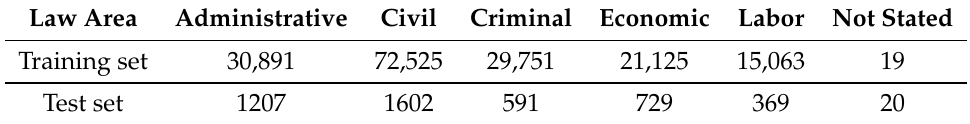
Table 2. Number of documents belonging to different law